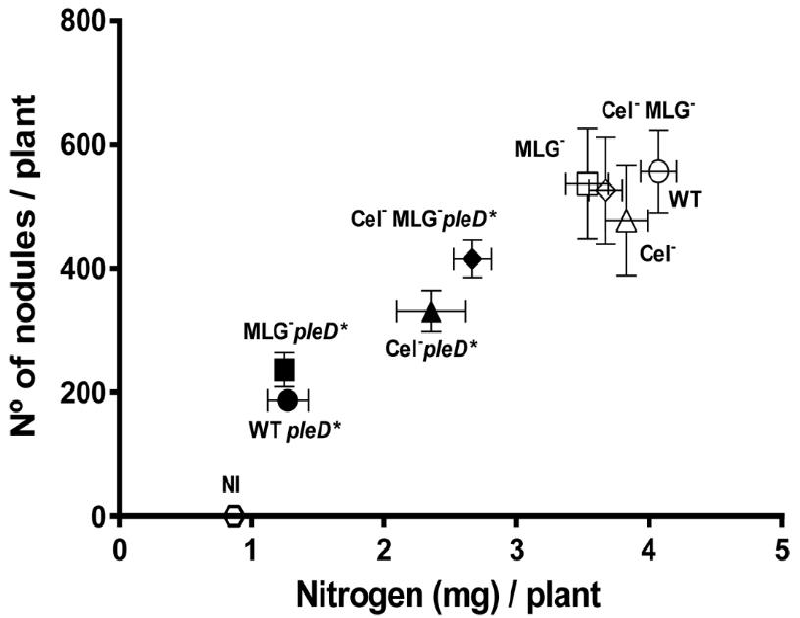
Figure 6. Role of β -glucans cellulose and MLG in the symbiotic interaction of R. etli CFN42 with bean plants. The symbols indicate the mean ± SEM of the nitrogen content of shoot versus the number of nodules per plant inoculated with single mutants in celAB cellulose genes (Cel − ), in bgsA (MLG − ), the double mutant (Cel − MLG − ) and their respective parental strains (WT) with (in black) or without pleD* (in white) plus the non-inoculated (NI) after 29 days.